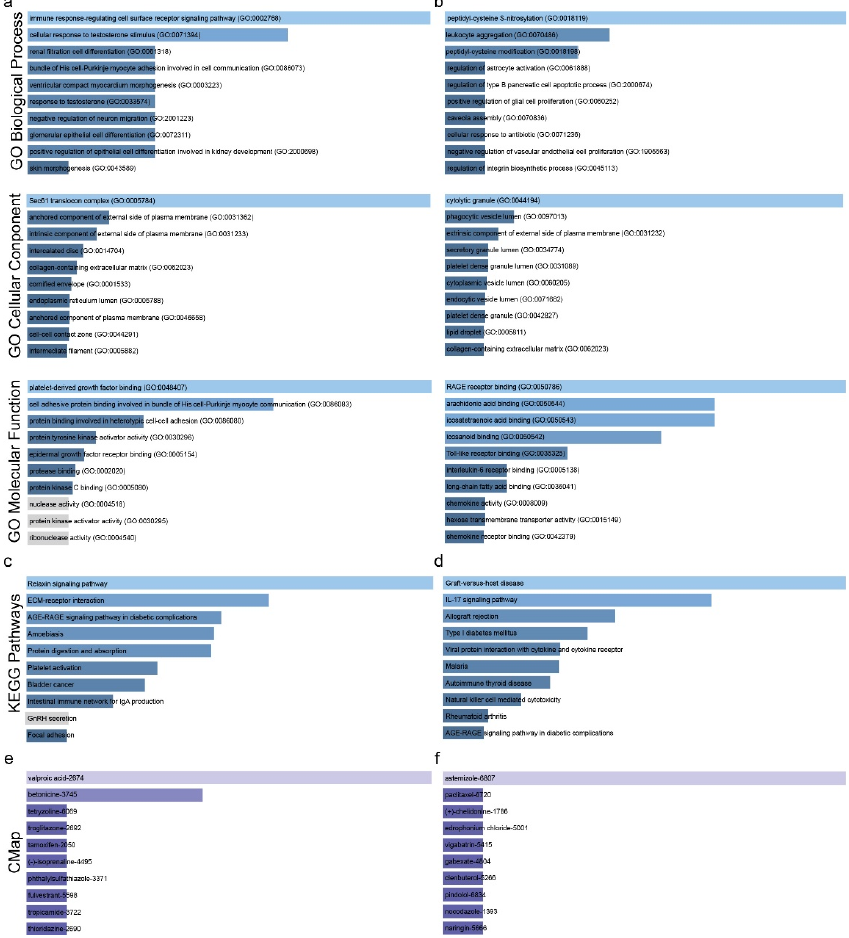
Figure 1. GO enrichment of the co-upregulated ( a ) and the co-downregulated ( b ) genes in lung cancer vs. the normal tissue. KEGG enrichment for the co-upregulated ( c ) and the co-downregulated ( d ) genes in lung cancer vs. the normal tissue. Repurposing drugs (CMap) tar- geting the co-up- ( e ) and co-downregulated ( f ) genes in lung cancer. Bar graphs were sorted using a combined score between the Benjamini–Hochberg (BH)-adjusted p -value and the z-score of the deviation from the expected rank. Each bar’s length shows the significance of the corresponding term, being relative to the color brightness of each